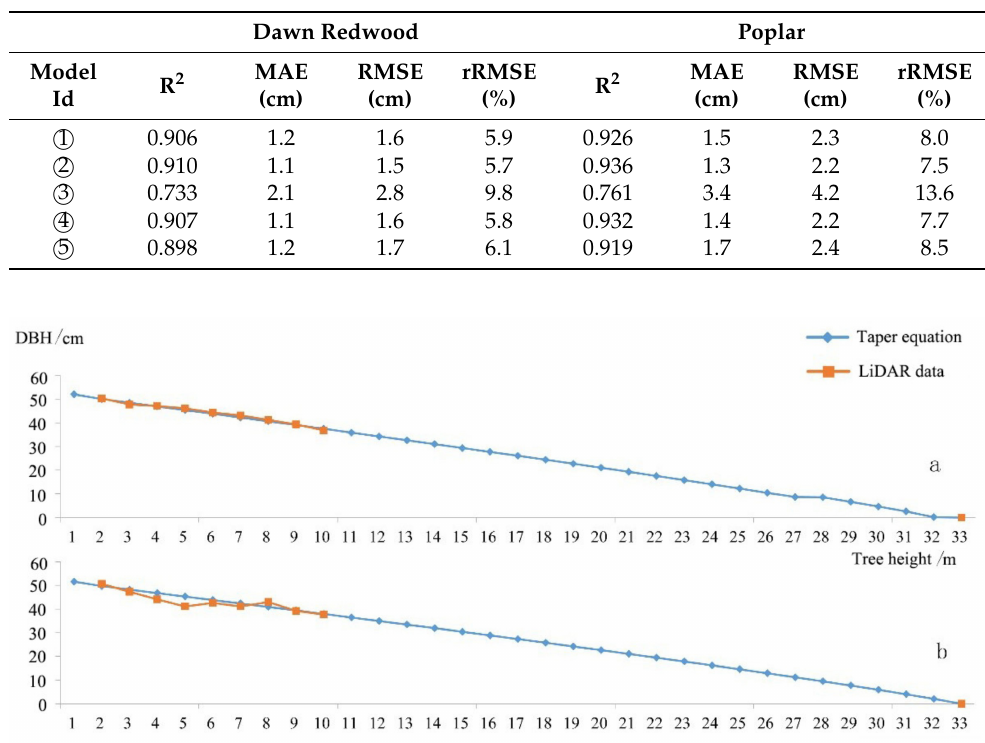
Figure 5. Scatterplots of the upper diameter of the trunk and the upper diameter of the trunk extracted using the LiDAR data for the five taper equation models for dawn redwood and poplar. ( a – e ) Dawn redwood, ( f – j ) poplar. Table 6. Assessment of the accuracy of the five models of dawn redwood and poplar.